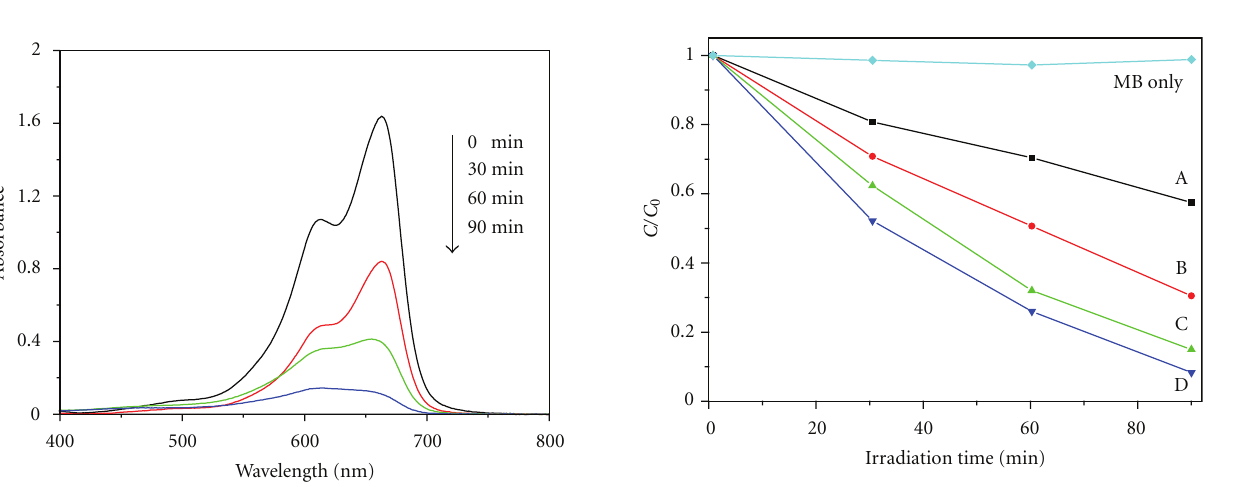
Figure 6: Absorption changes of MB aqueous solution at room temperature in the presence of the sample D under visible-light irradiation.